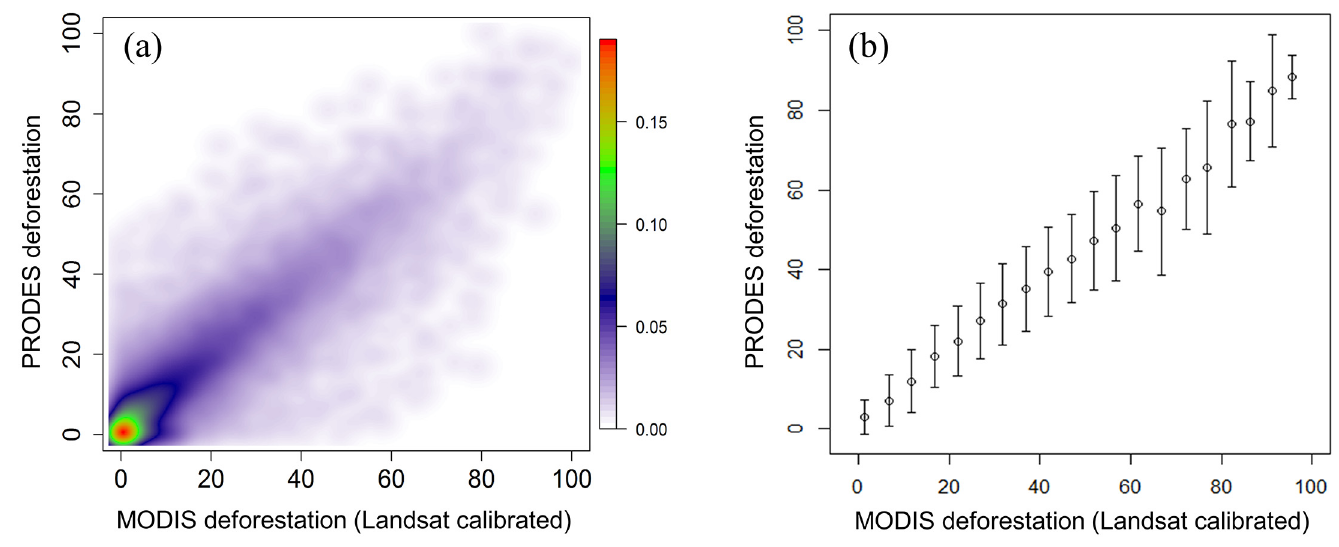
Fig 12. Estimating errors in MODIS-derived deforestation rates with PRODES as reference. (a) Density scatter plot with colours representing point density (n = 14,322). (b) Error bars represent ± one standard derivation of Landsat-derived deforestation rates for each deforestation level (bin = 5%).